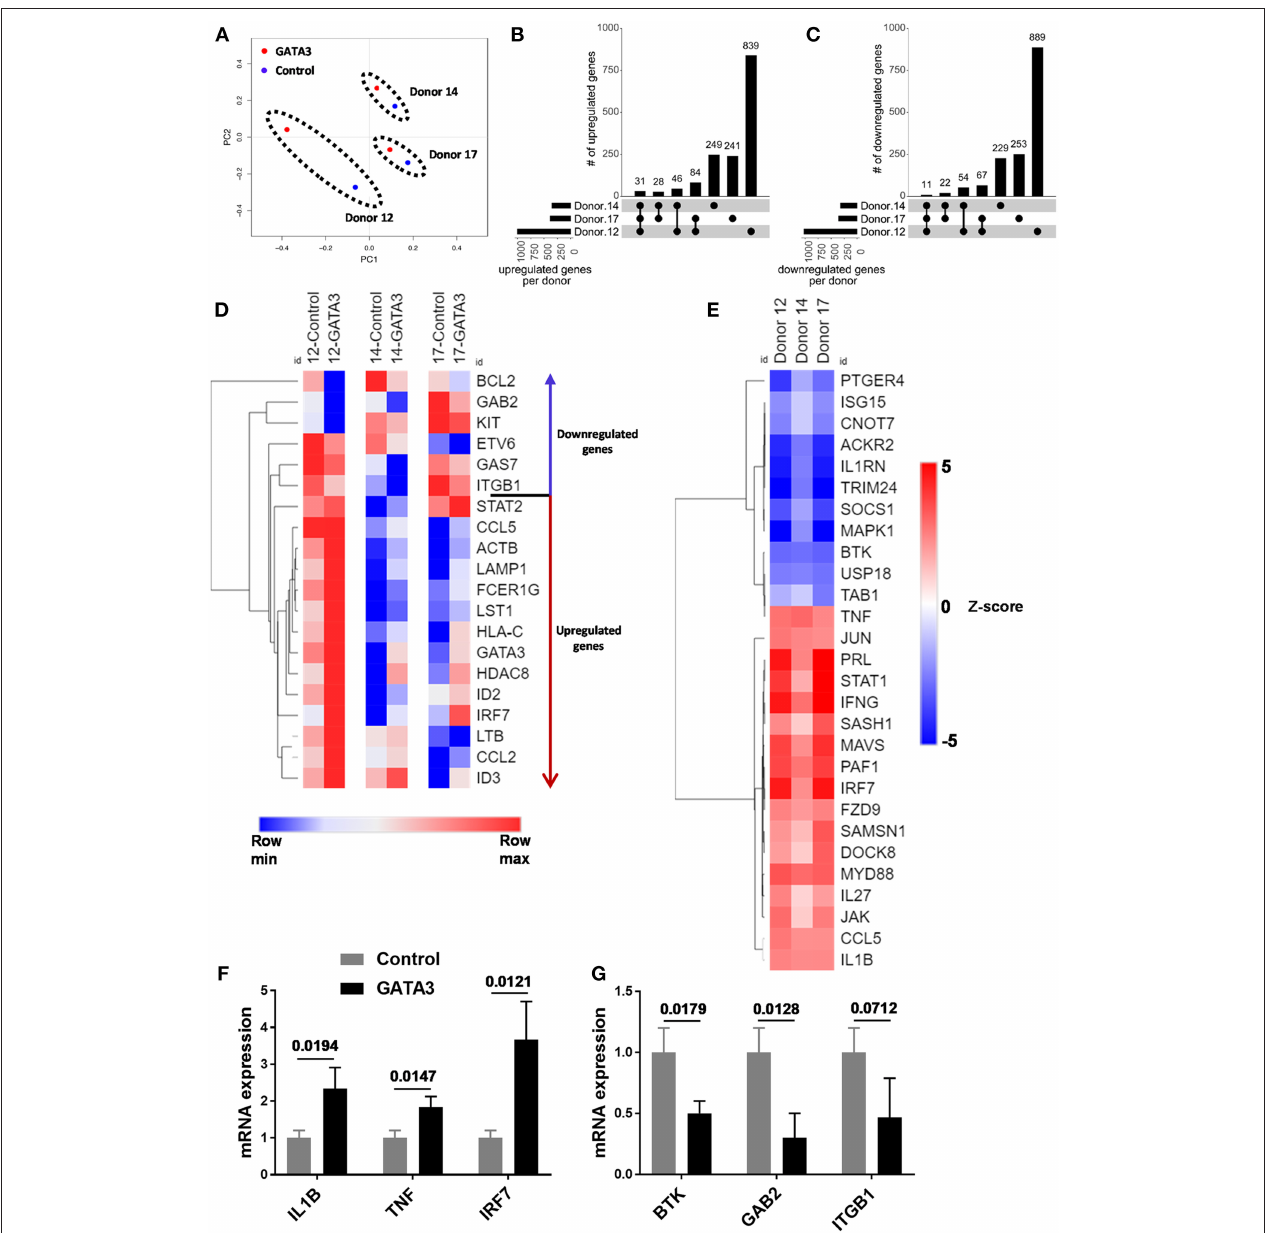
FIGURE 3 | GATA3 influences the gene expression profile of CD34 + HSCs. Five-day expanded UCB CD34 + HSCs were transfected with either GATA3 mRNA (GATA3) or scrambled mRNA (control) and RNA was extracted after 5 days of culture and qPCR or mRNA sequencing was performed for 3 independent donors across GATA3 transfected and control transfected cells. (A) The principal component analysis of global gene expression was performed in R and the result is shown as PCA plot. (B,C) The number of upregulated (B) and downregulated (C) genes, based on mRNA expression within each donor, as well as the overlap between donors are displayed as an UpSet plot. (D) Heat map showing log transformed differential expression for each donor pair (GATA3 vs. control) for genes altered by GATA3. (E) Significantly regulated genes by GATA3 mRNA were considered for each donors to perform upstream analysis using IPA. A heat map showing activation z-scores for statistically significant upstream regulators. (F,G) The quantitative expression of genes in GATA3 transfected cells is shown relative to its expression in control cells after normalizing to the expression of GAPDH ( n = 3/group), data are shown as mean ± SD, paired two-tailed t -tests and p -values are depicted.